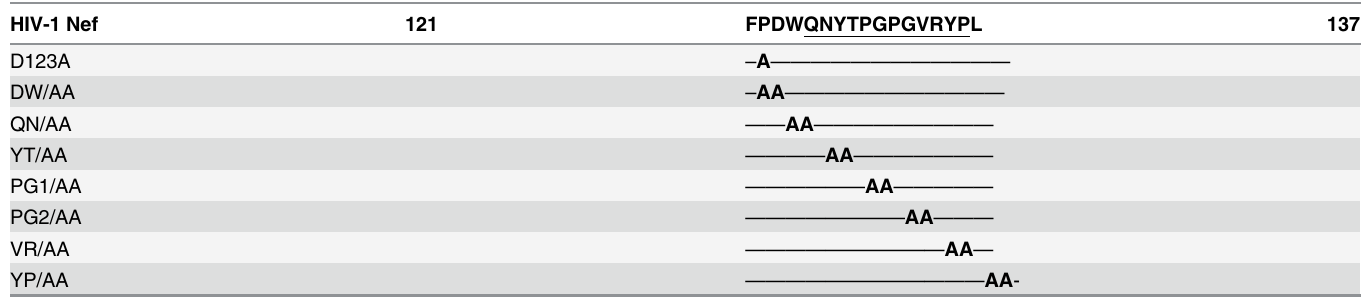
Table 1. Amino acid sequences of wild-type and mutated HIV-1 Nef NL4.3 from Phe121 to Phe137. HIV-1